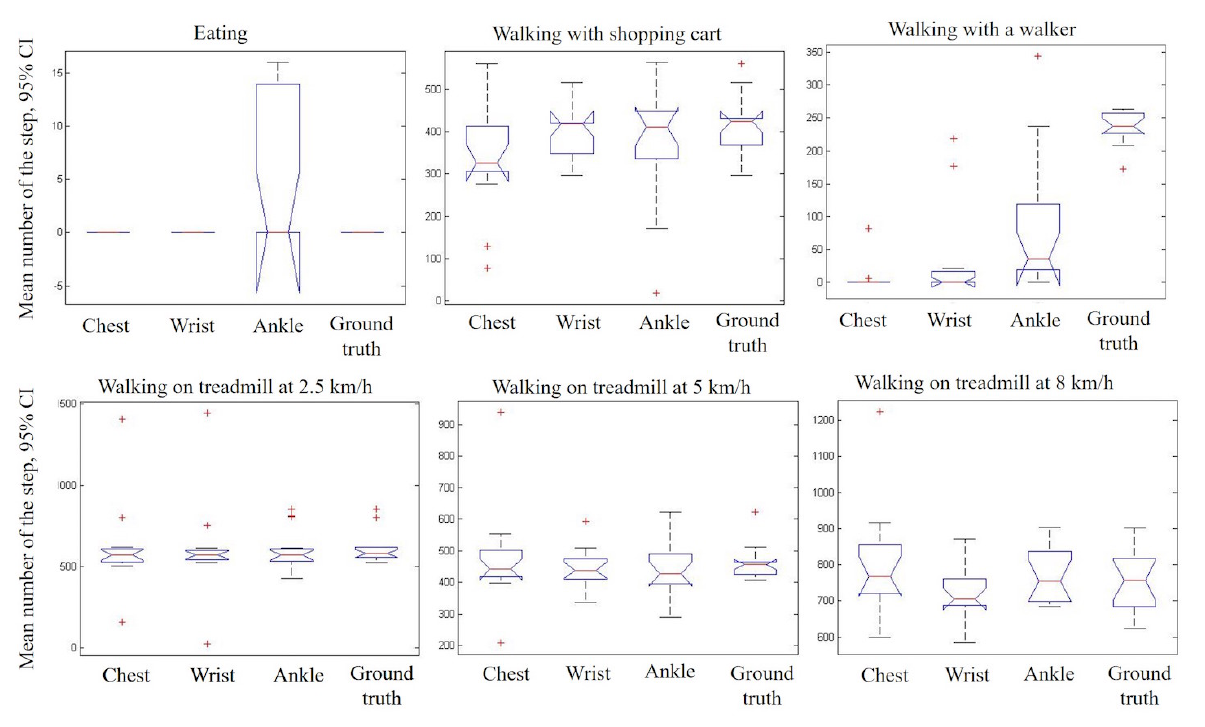
Figure 2. The result of the ANOVA tests on the steps recorded by trackers worn on different wearing sites (chest, pocket, and wrist) with the gold standard number of steps.